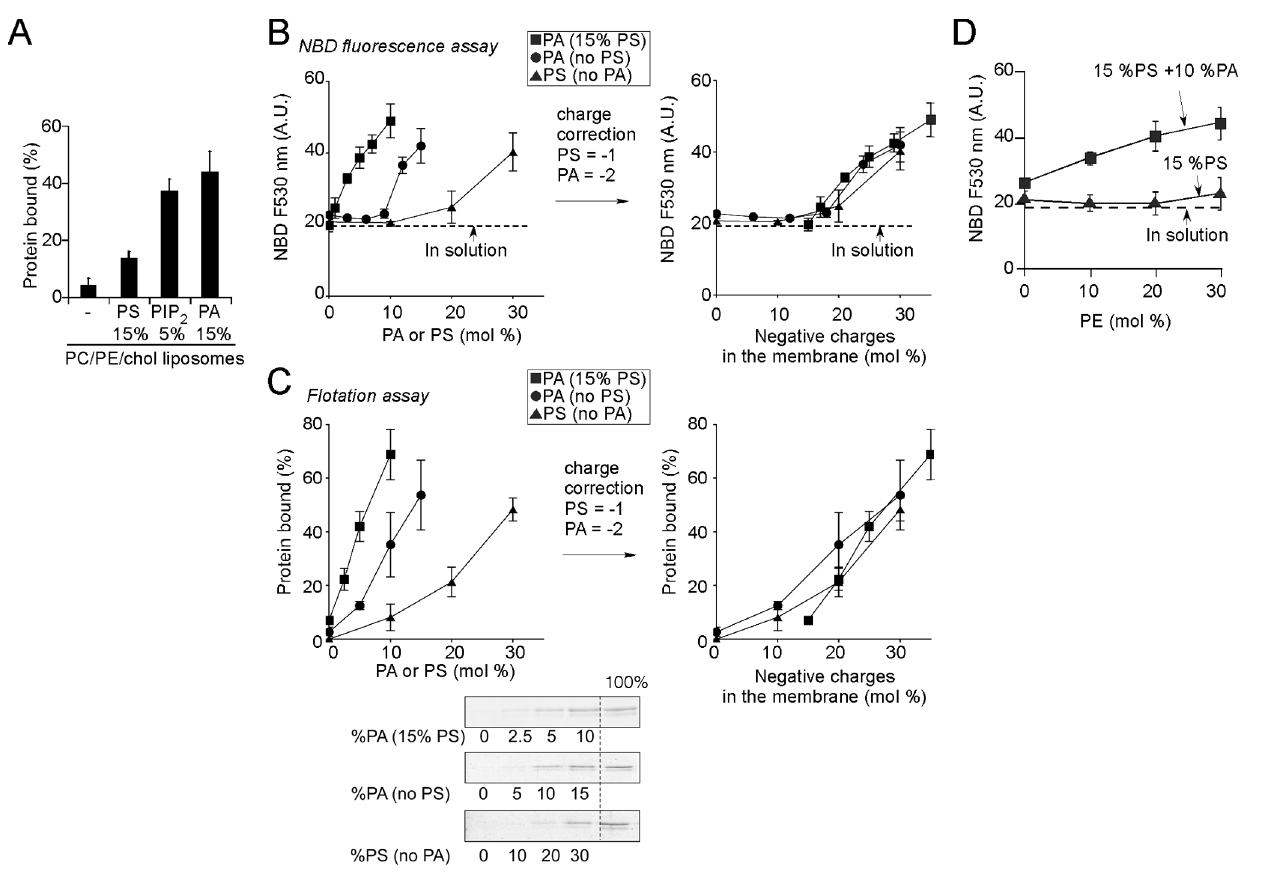
Figure 4. Membrane binding properties of the Spo20 bioprobe. ( A ) Spo20-GCC (0.75 m M) was incubated with or without PC/PE/Cholesterol liposomes (0.75 mM) containing (mol %) PE (25), cholesterol (25) and supplemented with PA (15), PS (30), or PIP 2 (5). The remaining lipid was PC. Bound proteins were recovered by flotation and analyzed by SDS-polyacrylamide gel electrophoresis using Sypro orange staining. ( B, C ) Binding of Spo20-GCC to liposomes containing (mol %) PE (25), cholesterol (25) and increasing amounts of PA (circles) or PS (triangles) as indicated. The remaining lipid was PC. A dose response curve for PA with liposomes containing 25 mol % PE, 25 mol % cholesterol and 15 mol % PS is also shown (squares). Membrane partitioning was assessed either by the NBD fluorescence assay ( B ) or by the liposome flotation assay ( C ). The data shown for the NBD assay are from two independent experiments. The horizontal dashed line indicates the fluorescence level of the NBD proteins in solution. The vertical bars show the standard deviation of the NBD fluorescence intensity of Spo20-GCC. For the flotation assay, the data shown are from two or three independent experiments with different preparations of liposomes. An typical SDS gel analysis is shown. The dose response curves are shown either as a function of the mol % of PA or PS (left) or as a function of the total amount of negative charges in the membrane (right). ( D ) Effect of PE on the membrane partitioning of Spo20-GCC as assessed by NBD fluorescence. The liposomes contained (mol %) PS (15), cholesterol (25), PA (0, triangles; 10, squares) and increasing amounts of PE at the expense of PC. All liposomes were prepared by extrusion through 0.2 m m